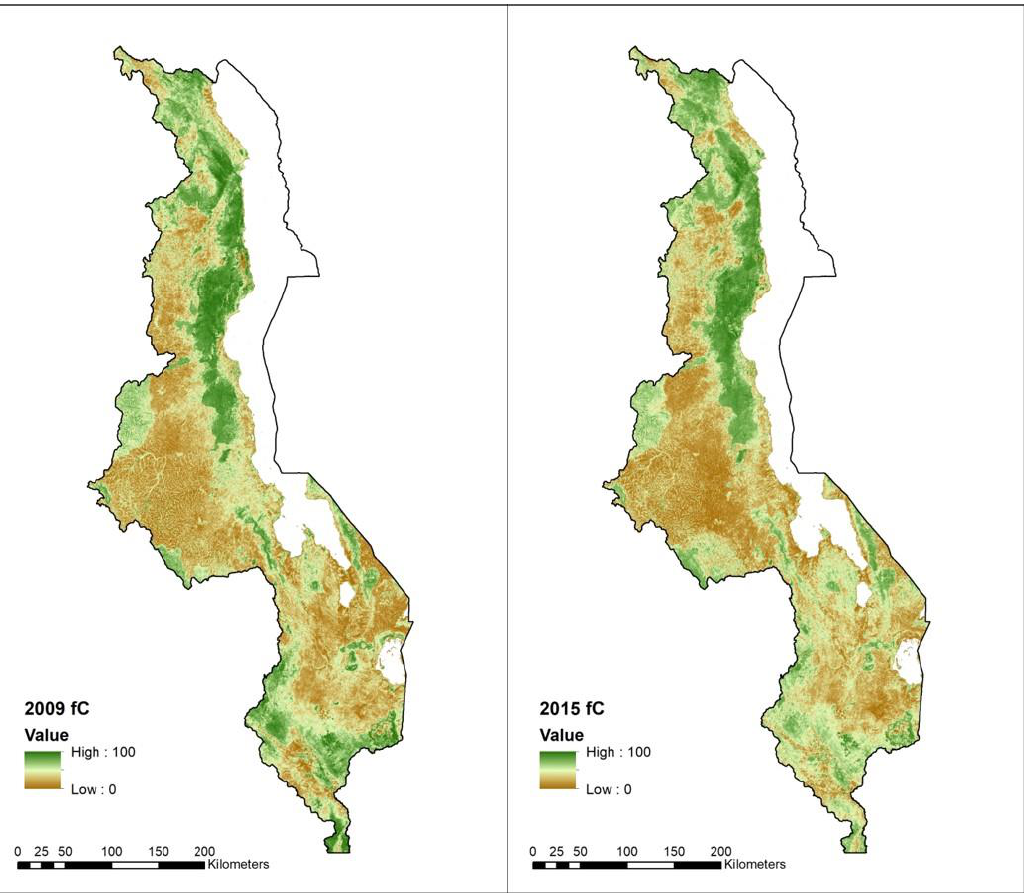
Figure 3. The fractional forest cover product for the years 2009 and 2015. The scale represents a continuous field gradient of values for f C, and subtraction of two dates produces a change product, ∆ f C, i.e., 2000–2009, 2010–2015.